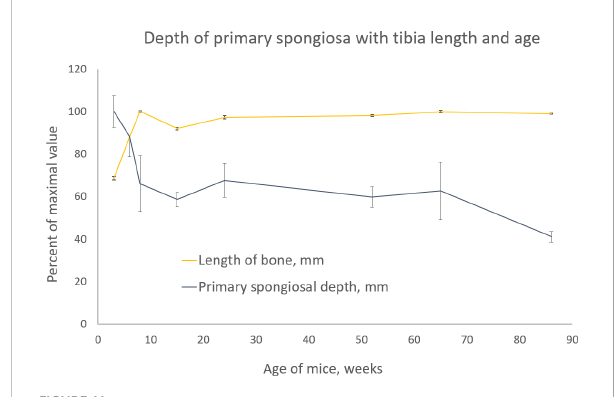
FIGURE 11 Tibia length (light orange) and primary spongiosal depth (dark blue) with the age of different groups of BL6 mice from 3 to 86 weeks. Please see text (methods) for the de fi nition and measurement of both quantities. Both parameters are shown as percentage of the maximal value for ease of comparison. The maximal tibia length was 18.2 mm in the 8-week age group, and the maximal primary spongiosal depth was 0.5 mm in the 3-week age